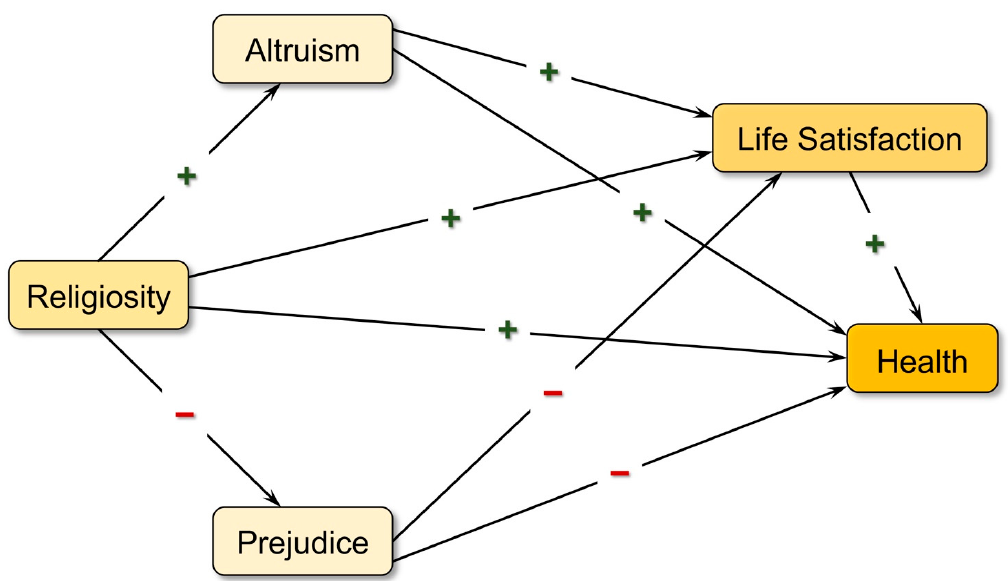
Figure 1. The Theoretical framework.